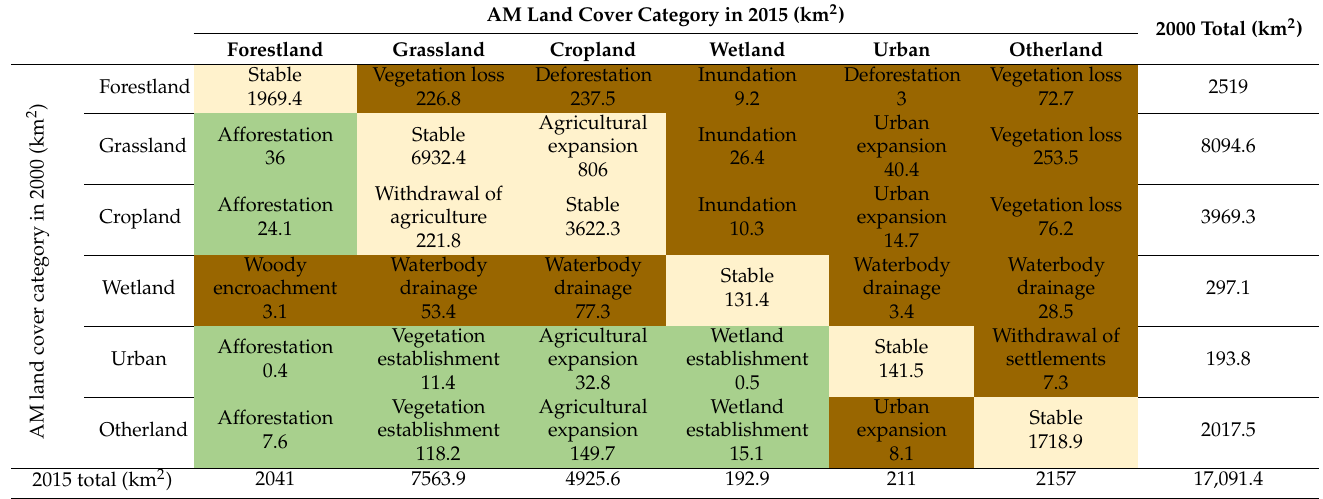
Table 2. Land cover transition matrix (2000–2015) based on the adapted methods (AM). Green, beige and brown colors indicate improving, stable and declining conditions of land cover categories, respectively. The area in km 2 and the possible cause of the land cover transition are indicated in the matrix. The change is based on the high-resolution land cover